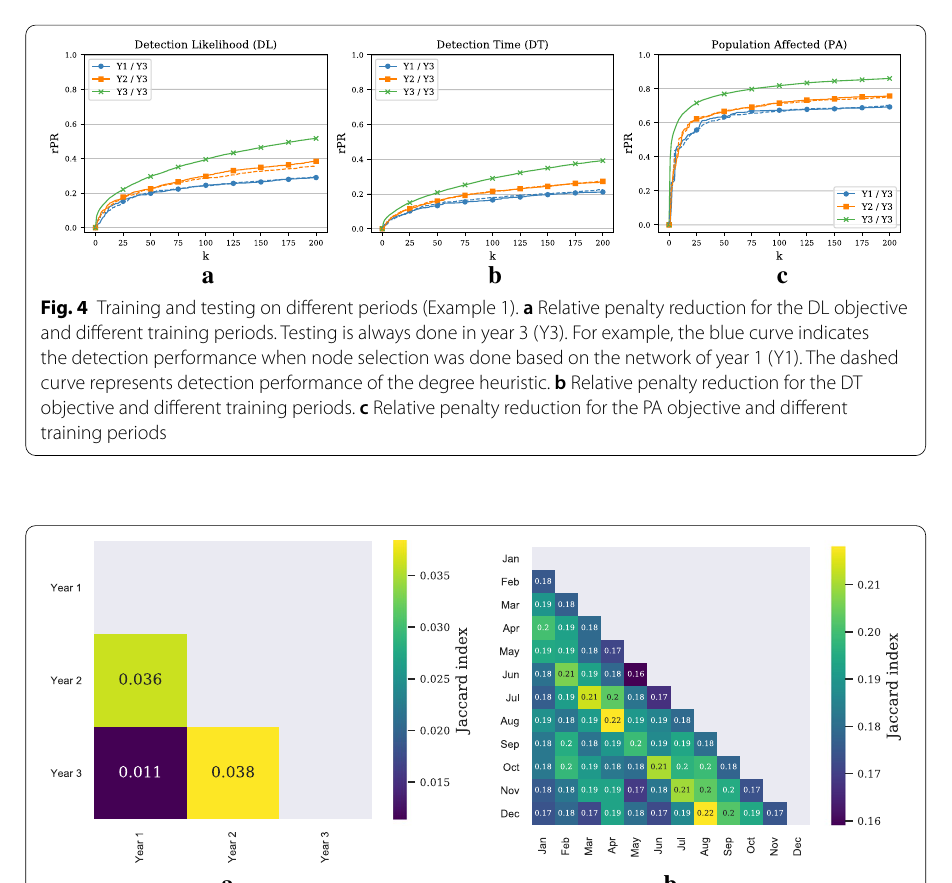
Fig. 5 Overlap matrices (Example 1 and 2). a Overlap matrix between periods for Example 1. The overlap is measured by the Jaccard index. We compare the unique sets of static edges between periods. b Overlap matrix between periods for Example 2. Here, we compare the unique sets of static directed edges